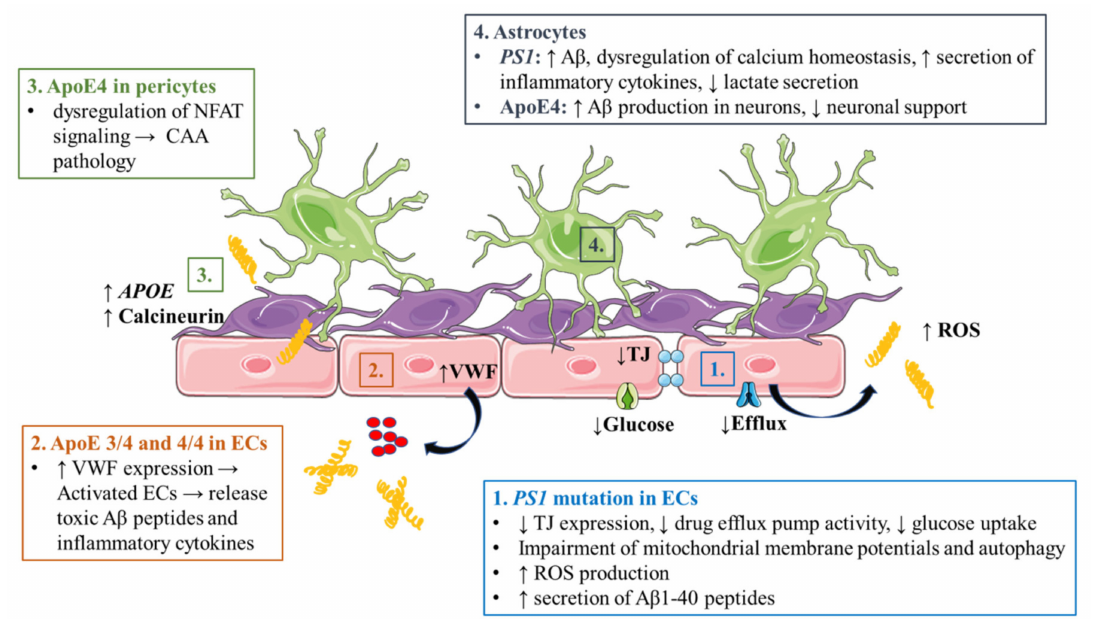
Figure 1. Schematic illustration of BBB dysfunction in AD based on iPSC-BBB